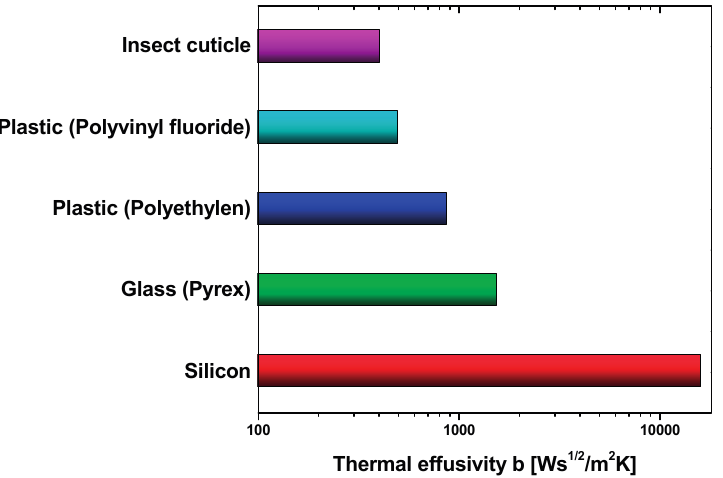
Figure 14. Comparison of the thermal effusivity, b , for different materials (Polyvinyl fluoride under the trade name Tedlar ® is a registered trademark of DuPont; Pyrex ® is